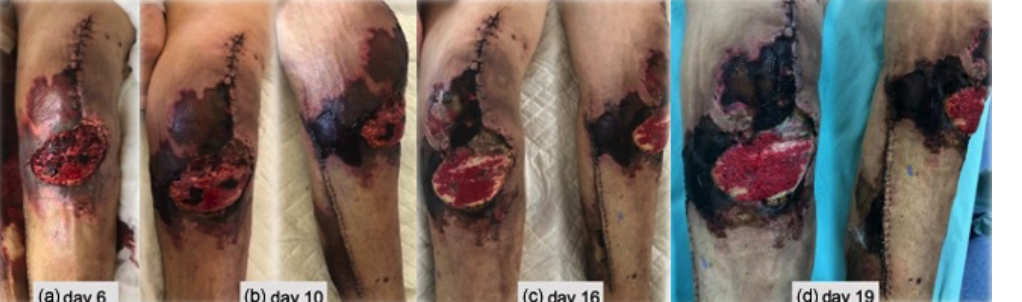
Figure 3. (a–d) Skin necrosis progression after TKA revision, extending to the lower leg around the incision made to harvest the muscle flap.